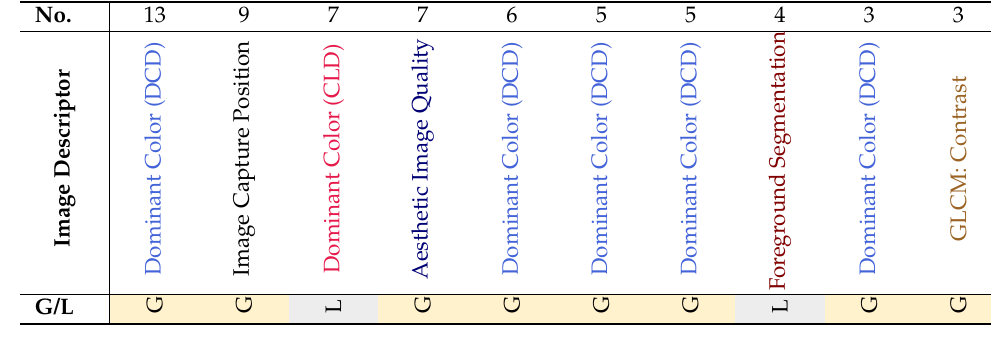
Table 2. Ranking of the most influential image descriptors in distinguishing correct from incorrect detections. Dataset: R-UAV test data; synthetically trained detector model. GLCM: Gray Level Co-Occurrence